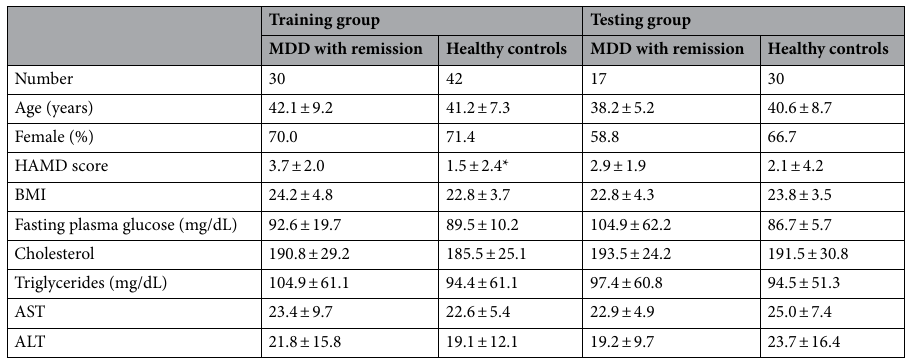
Table 1. Demographic variables and biochemical indices in the MDD patients with full remission and the healthy controls. Full remission was defined as a HAMD score ≤ 7. MDD major depressive disorder, HAMD Hamilton Depression Rating Scale, BMI body mass index, ALT alanine aminotransferase, AST aspartate aminotransferase. * p <